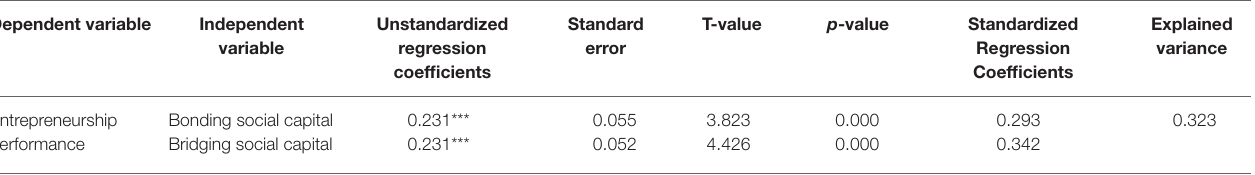
TABLE 5 | Structural model results.